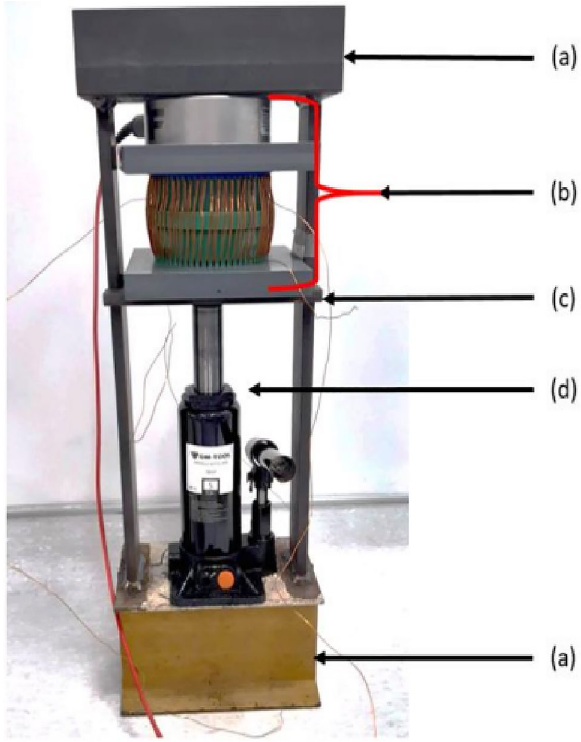
Figure 3. Global mock-up; ( a ) fixed structure of the press; ( b ) see Fig. 4; ( c ) movable steel plate; ( d ) hydraulic jack.